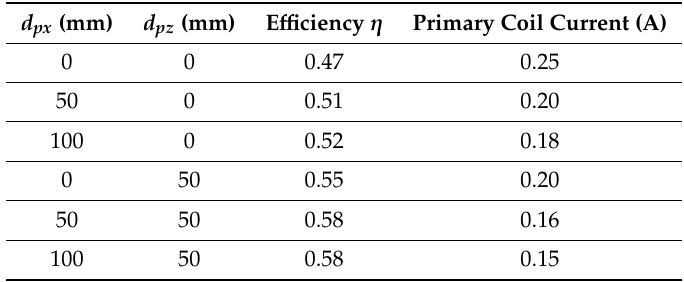
Figure 20. Output power P out vs. inclination angle θ .